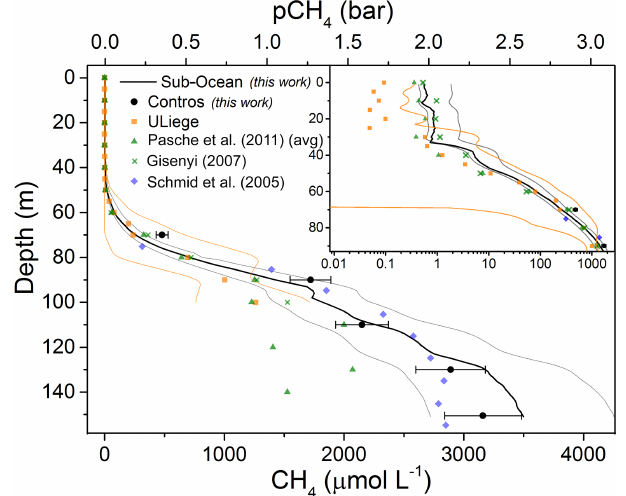
Figure 6. Continuous methane profile of the upper 150m of water depth in Lake Kivu measured by the Sub-Ocean instrument (black line). Grey lines represent the measured variability over the eight continuous profiles estimated between 0 and 80m depth and fixed to the estimated uncertainty of ± 22% at larger depths. Black dots are discrete measurements made with the Contros HydroC ® HP sensor at different depths. Error bars correspond to the estimated uncertainty of ± 10%. Orange squares are from the long-term mon- itoring undertaken by the University of Liege (Roland et al., 2017, 2018) with the corresponding 3 σ variability (orange lines). Green triangles are average concentrations from Pasche et al. (2011) from three different campaigns conducted in May 2006 and 2007 at dif- ferent locations (Kibuye, Ishungu and Gisenyi). Green crosses are data from Gisenyi (2007) from Pasche et al. (2011). Blue rhom- buses correspond to measurements from Schmid et al. (2005) in the northern basin using a commercial Capsum Met sensor (Schmid et al., 2005). In the inset a zoomed-in view of the shallow data is presented with a log scale on the concentrations allowing a better comparison of the different